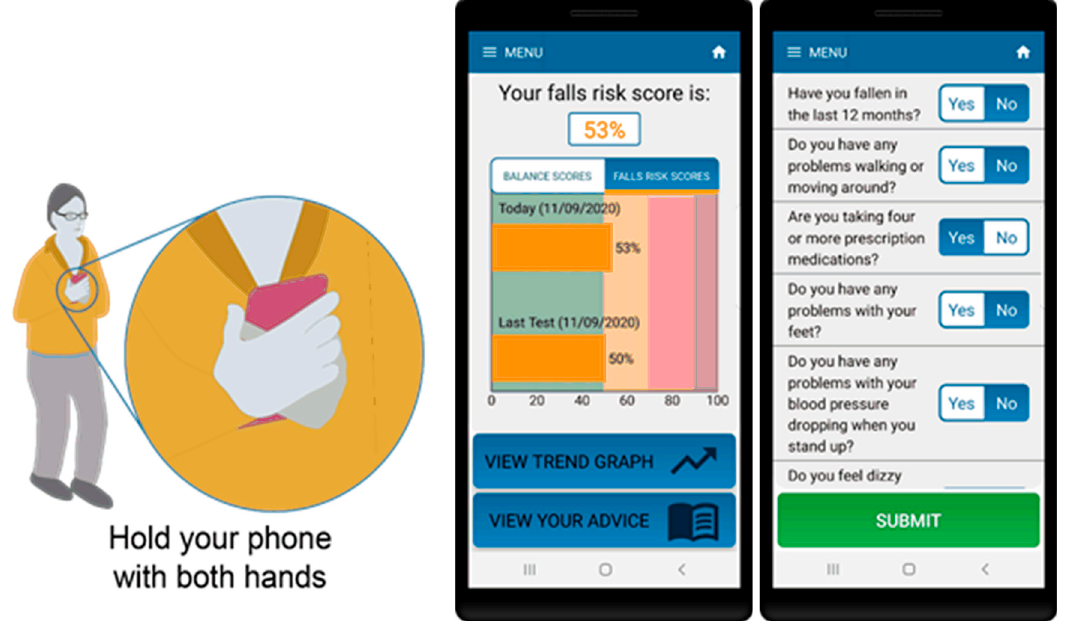
Figure 1. Smartphone app for assessment of balance and falls risk using questionnaire and standing balance test (in semi-tandem stance).